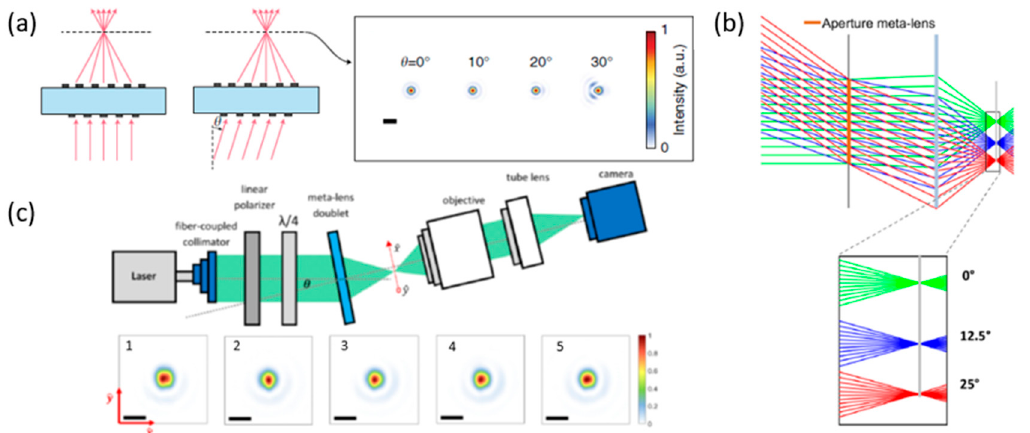
Figure 1. Focal spot characterization for different angles of incidence source. ( a ) ( left ) Schematic illustration of focusing of on-axis and off-axis light by a metasurface doublet lens. ( right ) Simulated focal plane intensity for different incident angles. (Reproduced from [24] with permission.) ( b ) The Ray diagram obtained by adding the aperture meta-lens resulting in diffraction-limited focusing along the focal plane. ( c ) Focal spot measurement setup. (1–5) Focal spot intensity profile at (1) 0°, (2) 6°, (3) 12°, (4) 18°, (5) 25° incidence angle. (Reproduced from [25] with permission.)